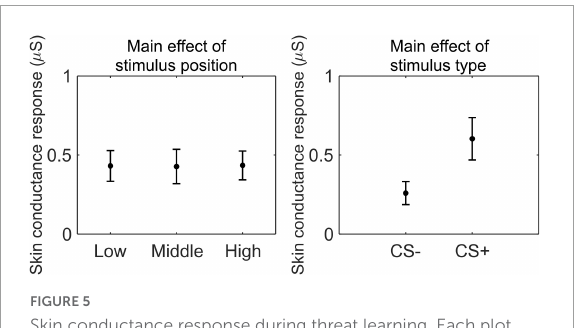
FIGURE5 Skin conductance response during threat learning. Each plot shows the group mean (black dot) and 95% confidence intervals (vertical bars) of the skin conductance response as a function of the stimulus position or the stimulus type.